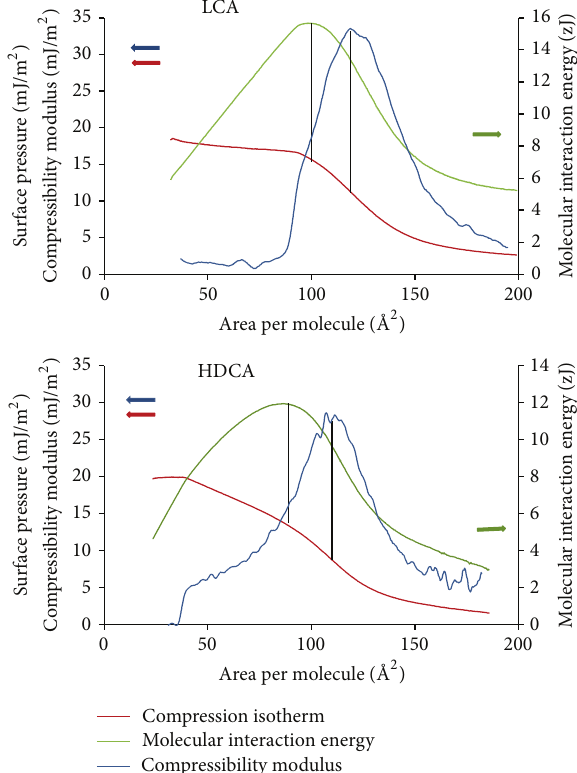
Figure 6: Compression isotherms (3M NaCl, pH = 1.2 subphase at 25 ∘ C), compressibility modulus, and molecular interaction energy functions of LCA and HDCA. Surface pressure unit is expressed in mJ/m 2 instead of the commonly applied